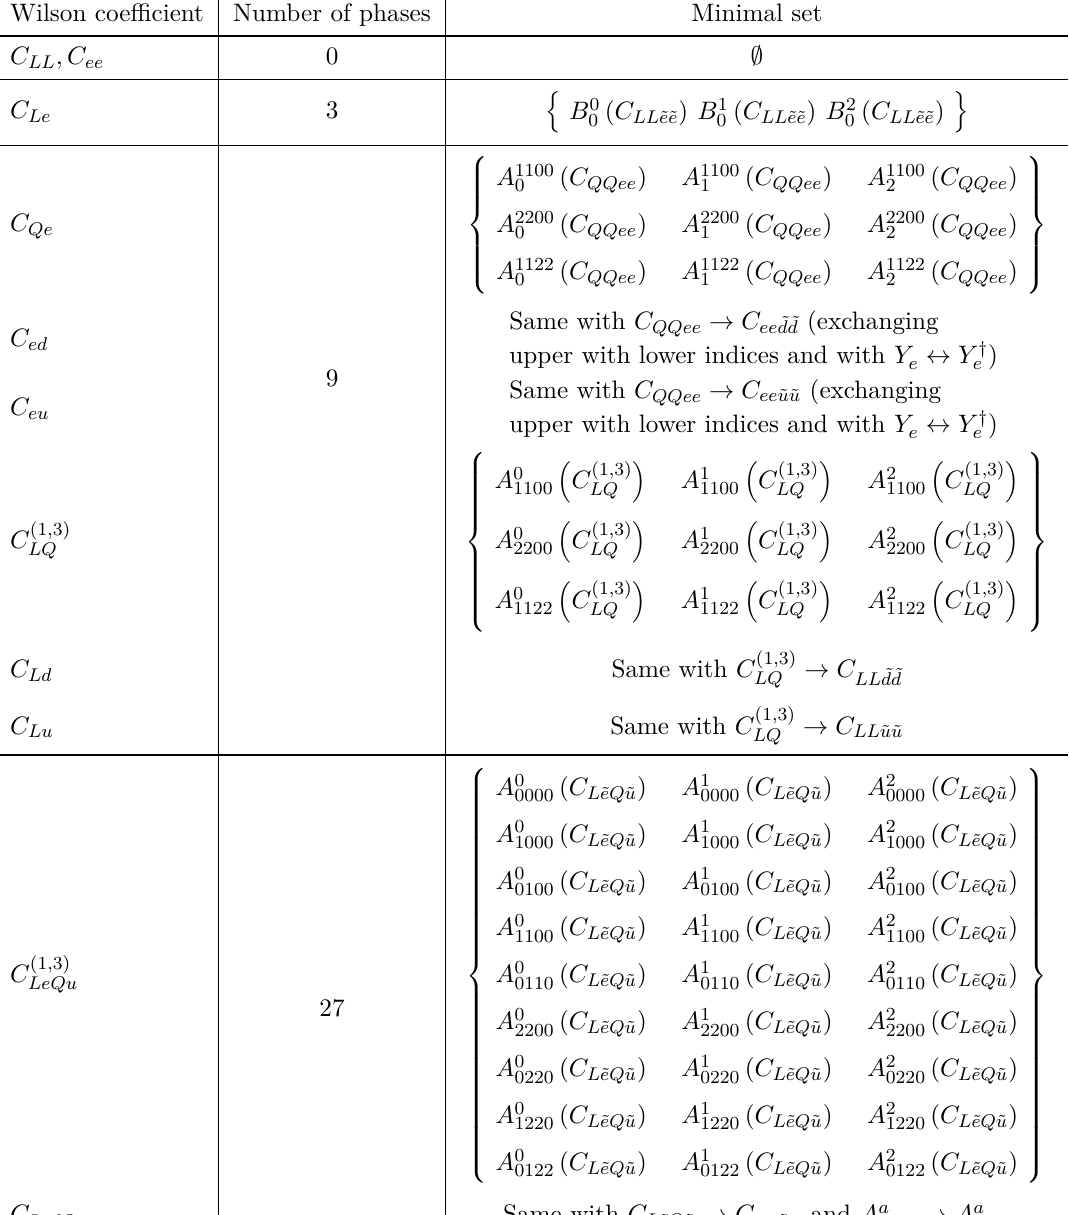
, and similarly for down quarks or electrons. We use the generalized u (cid:0) (cid:1) (cid:0) (cid:1) ( C ) ≡ Tr A X a , X b , C , B a ( C ) ≡ Tr B X a , X b , C with a, b = 1 , 2 e e e e b b